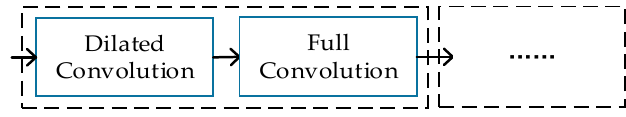
Figure 4. Illustration of the dilated perception unit structure.